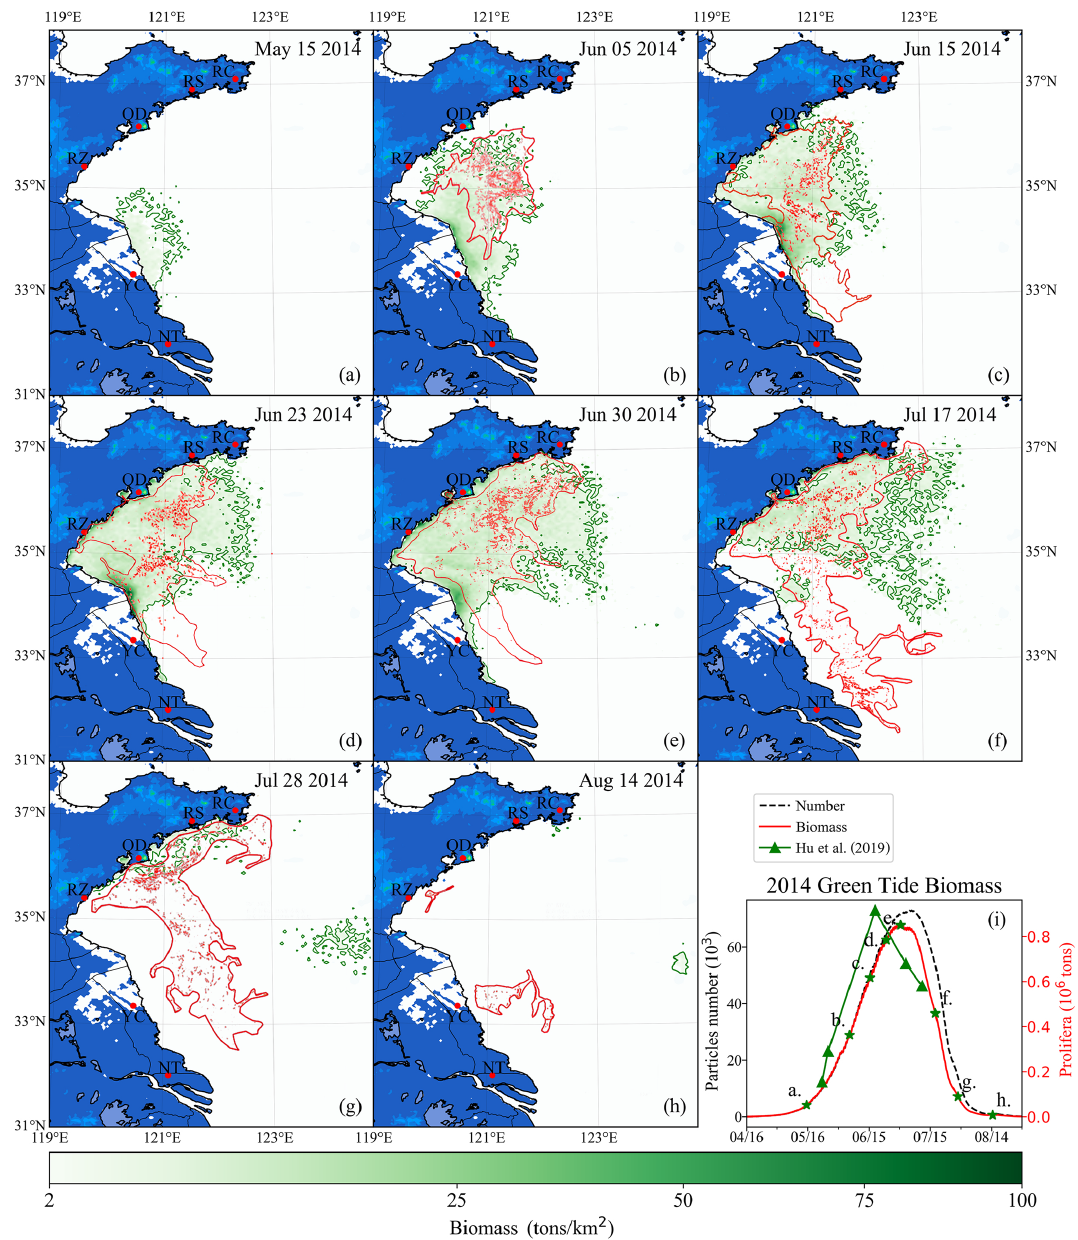
Figure 10. Comparison between simulation and remote-sensing observation of green tides from May to August 2014 (a–h) . The green image indicates the simulated biomass density of the green tide (color image, unit: tkm − 2 ). The red image shows the satellite-derived spatial coverage of U. prolifera from MODIS-Terra. Panel (i) is the time series of simulated biomass and particle number of green tides in 2014, compared with observed biomass from Hu et al. (2019). The green stars in panel (i) indicate the biomass of the corresponding date in panels (a) – (h)